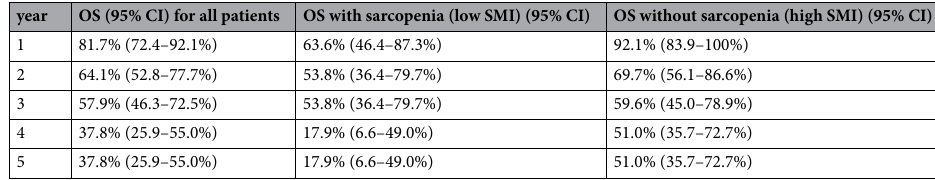
Table 4. Overall survival rates for sarcopenia. CI confidence interval, OS overall survival, SMI skeletal mass muscle